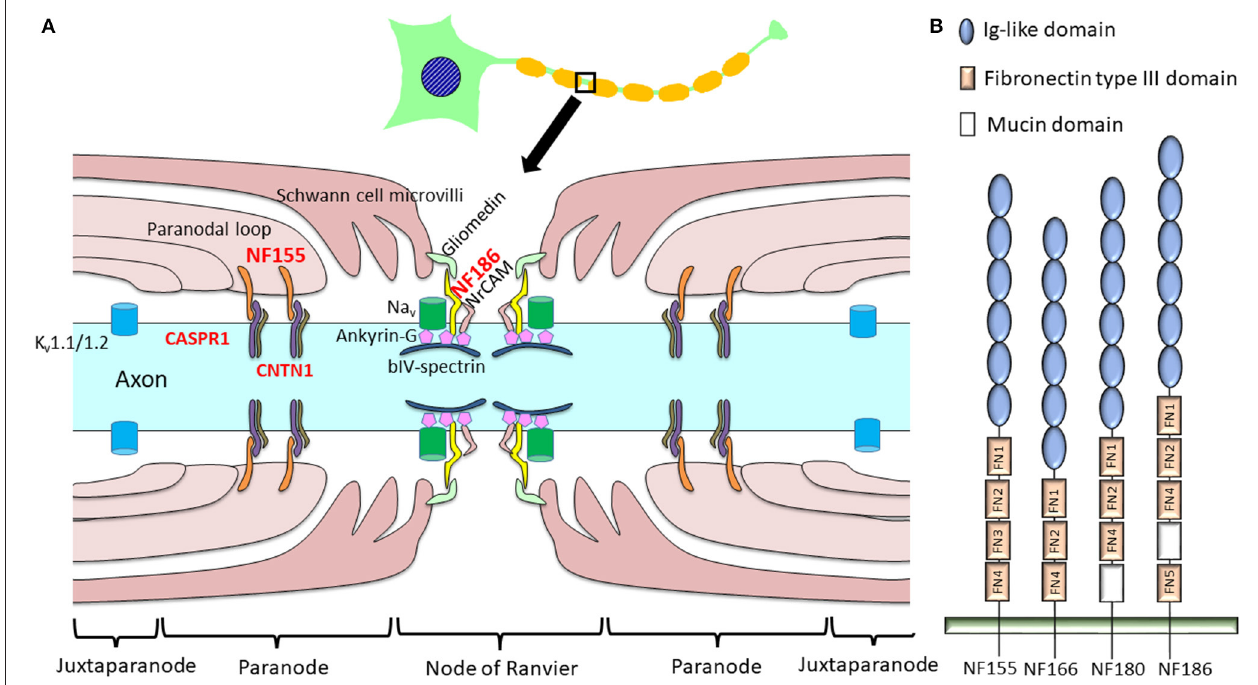
FIGURE 1 | Schema of a node of Ranvier indicating proteinaceous antigens targeted by anti-nodal/paranodal antibodies in chronic inflammatory demyelinating polyneuropathy (CIDP). (A) In CIDP, autoantibodies to NF155, NF186, CNTN1, and CASPR1 have been discovered, while antibodies against NF186, gliomedin, and contactin were also reported in a minority of patients with Guillain–Barré syndrome (28). (B) Schematic diagram of the different neurofascin isoforms. In the mature nervous system, neurons express NF186 while oligodendroglia express NF155. NF180 and NF166 are present in immature neurons ( 17). NF155 and NF186 differ in their extracellular domains: NF155 has FN3, but NF186 lacks this domain and instead harbors a mucin domain between FN4 and FN5. CASPR1, contactin-associated protein 1; CNTN1, contactin 1; FN, fibronectin type III domain; Ig, immunoglobulin; K v , potassium channel; Na v , sodium channel; NF, neurofascin; NrCAM, neuronal cell adhesion